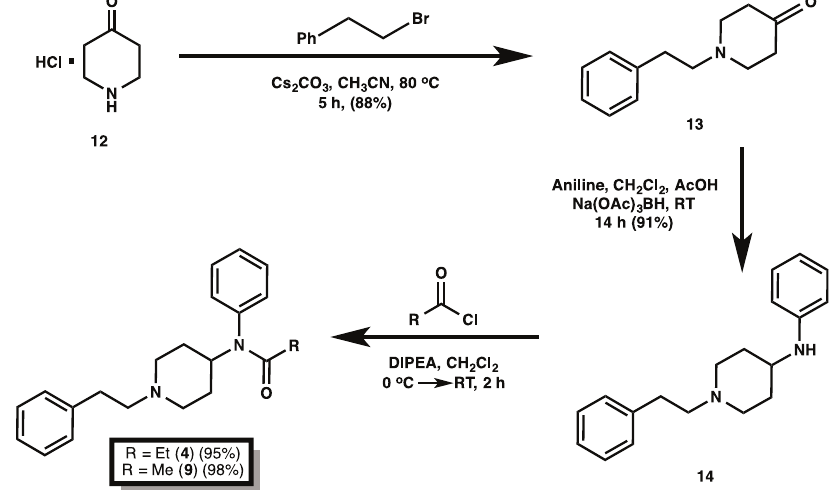
Figure 4. Synthesis of fentanyl and acetylthiofentanyl. Yields reflect the isolated materials by column chromatography after each step and using the optimized conditions (cf. Table 1). Citrate and hydrochloride salts for each analog were obtained in nearly quantitative yields by treating the free bases at the end of these routes with the corresponding acids.